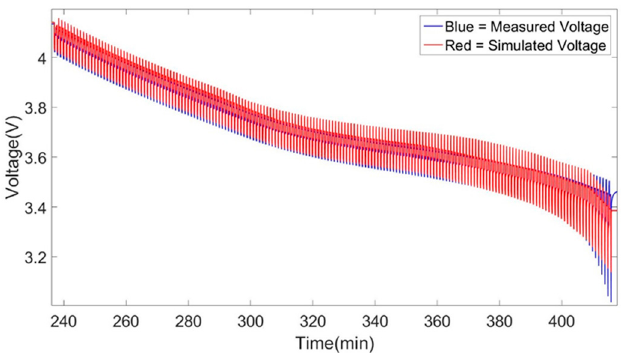
Figure 10. 1st order Thévenin model measured and simulated dynamic discharge pulse (DDP) comparison at 25 °C with Coulomb counting and normal characterization.